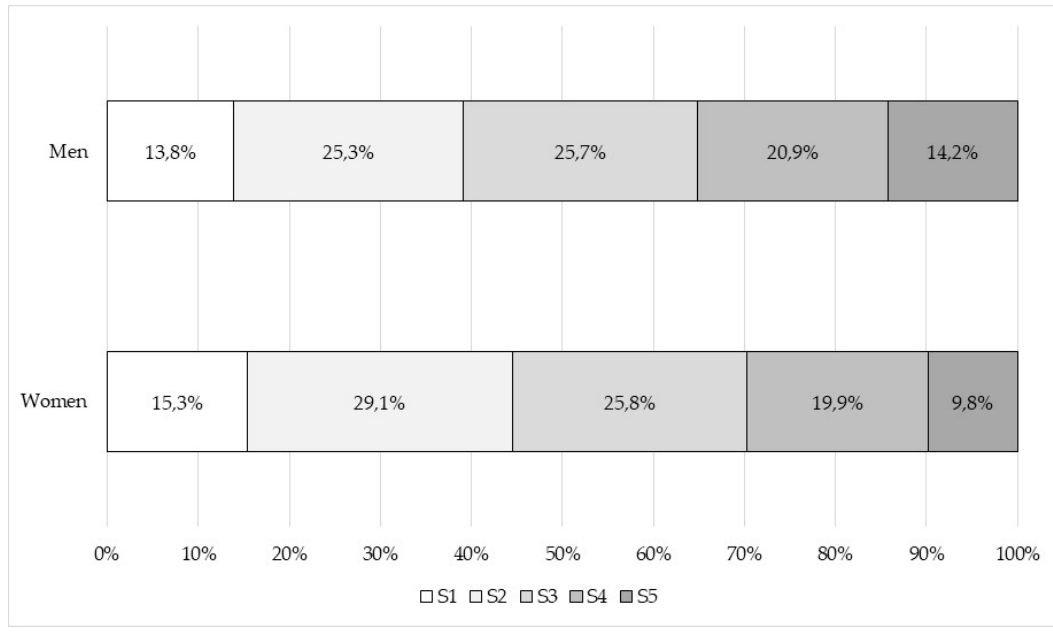
Figure 3. Social acceptance index (SAI) percentage distribution within gender categories.